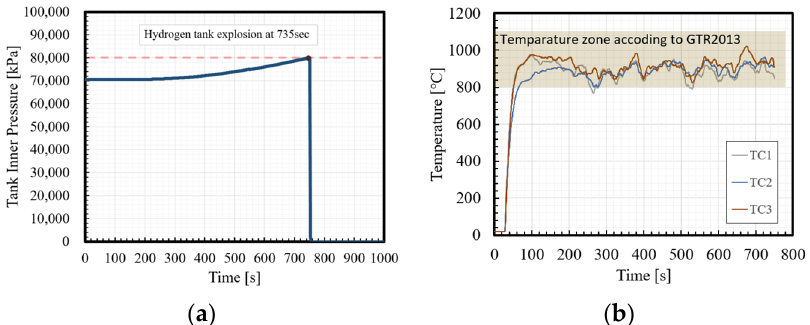
Figure 4. Tank internal pressure and heating temperature during the test: ( a ) internal pressure of hydrogen tank during heating; ( b ) temperature of heating source during experiment.